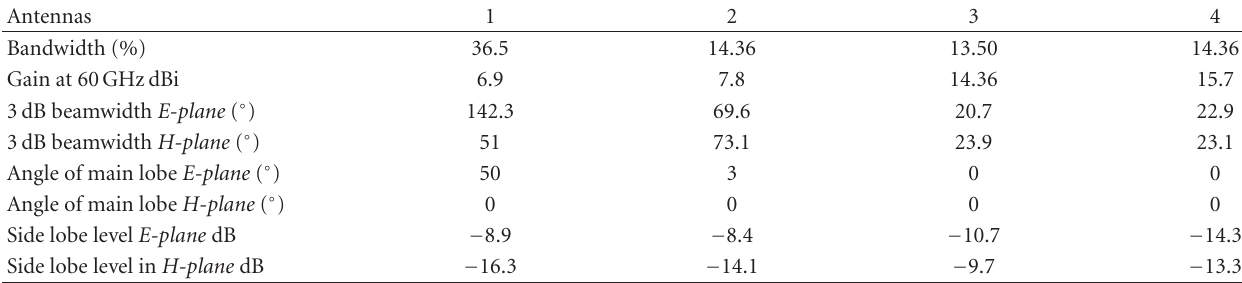
Table 3: Comparison of the characteristics of the proposed